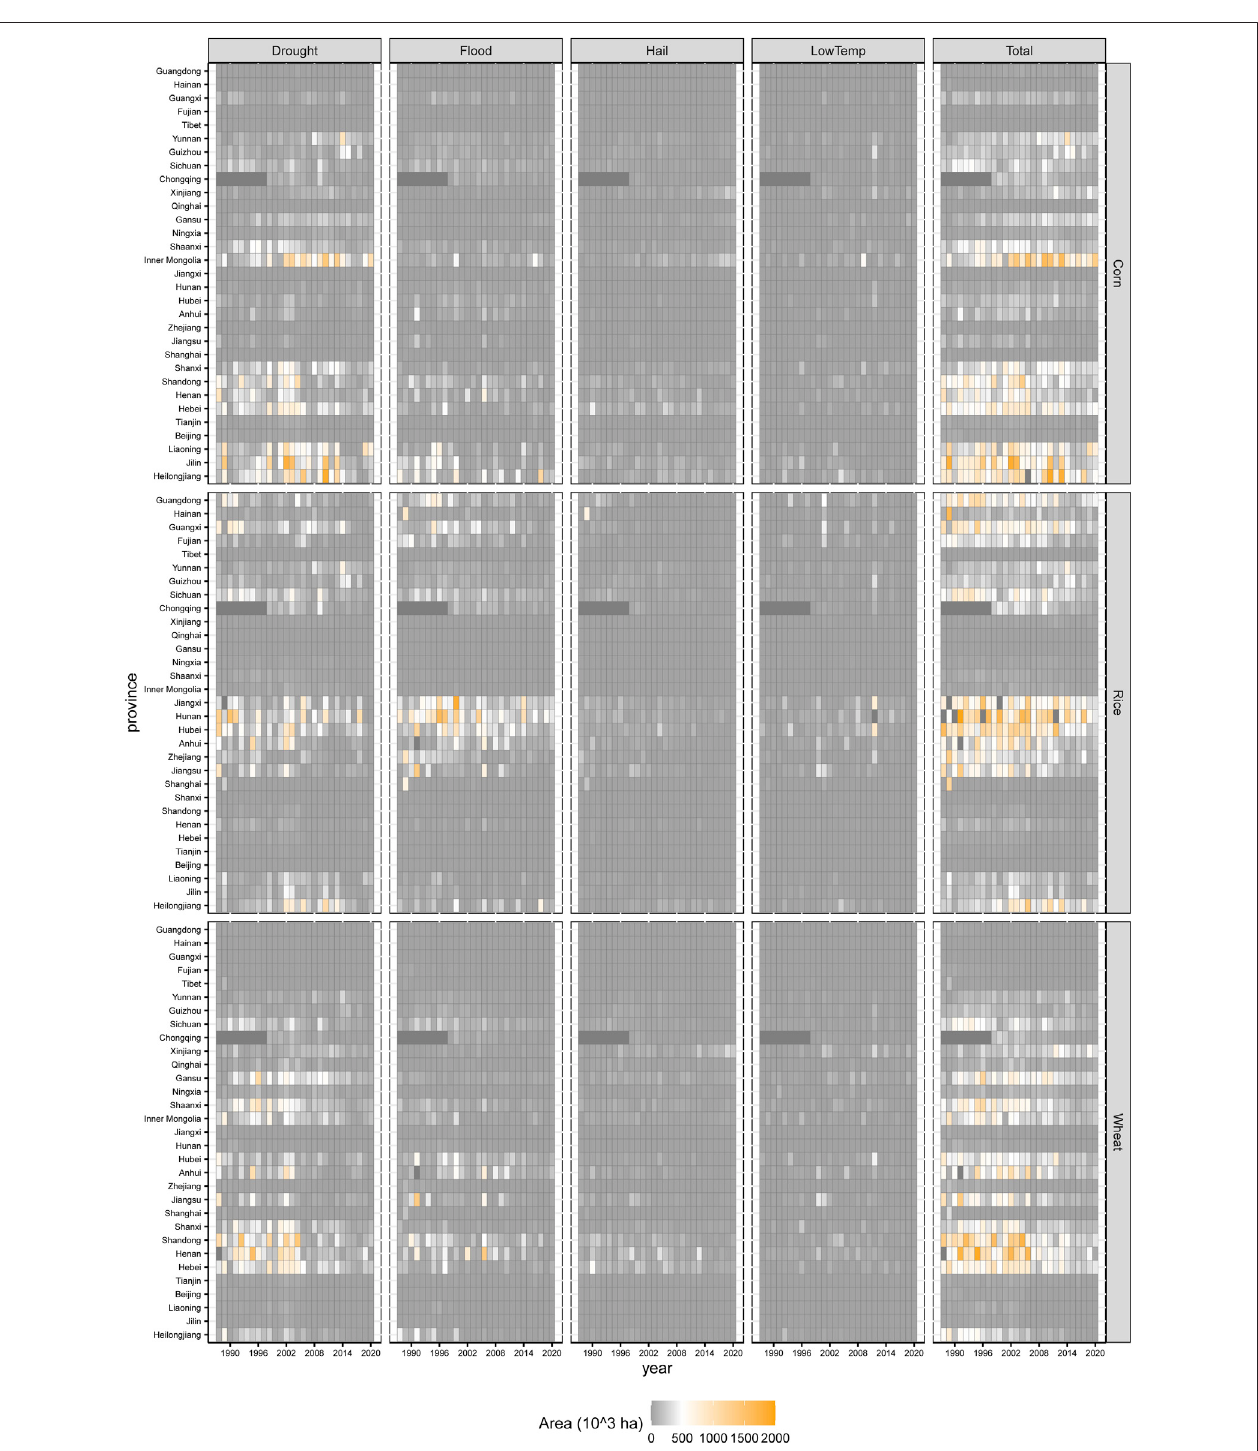
FIGURE 6 | Changes in the area affected by different moderate natural disasters for rice, maize, and wheat in each province from 1988 to 2020.